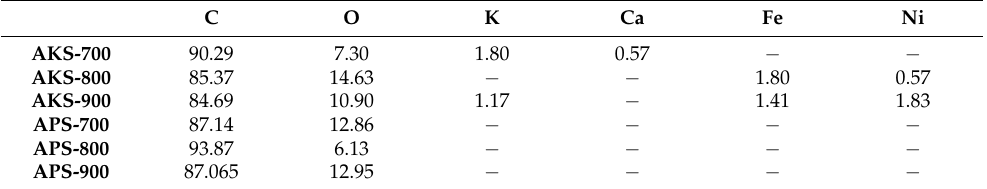
Table 2. Elemental composition of samples AKS and APS (atomic concentration, at.